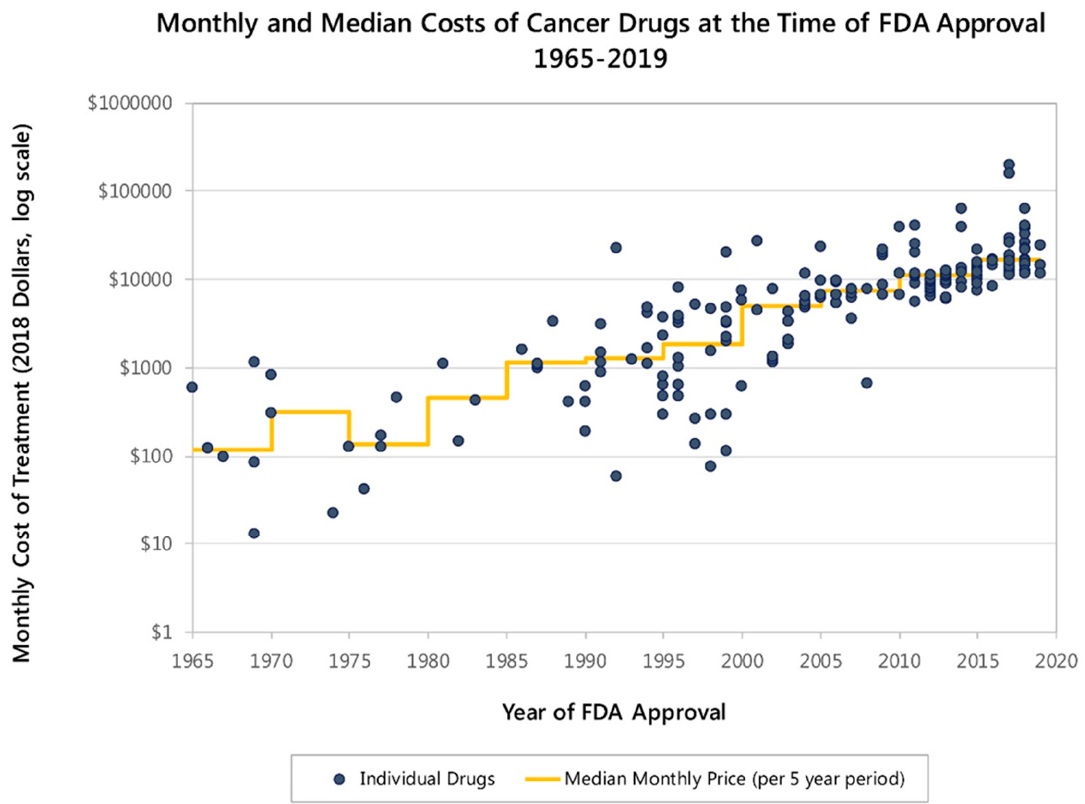
Figure 1. Monthly and median costs of cancer drugs at the time of FDA approval (1965–2019). Courtesy of Peter B. Batch, MD, Memorial Sloan Kettering Cancer Center. Source: https://www.mskcc.org/research ‐ programs/health ‐ policy ‐ out ‐ comes/cost ‐ drugs (Accessed on 14 July 2021).